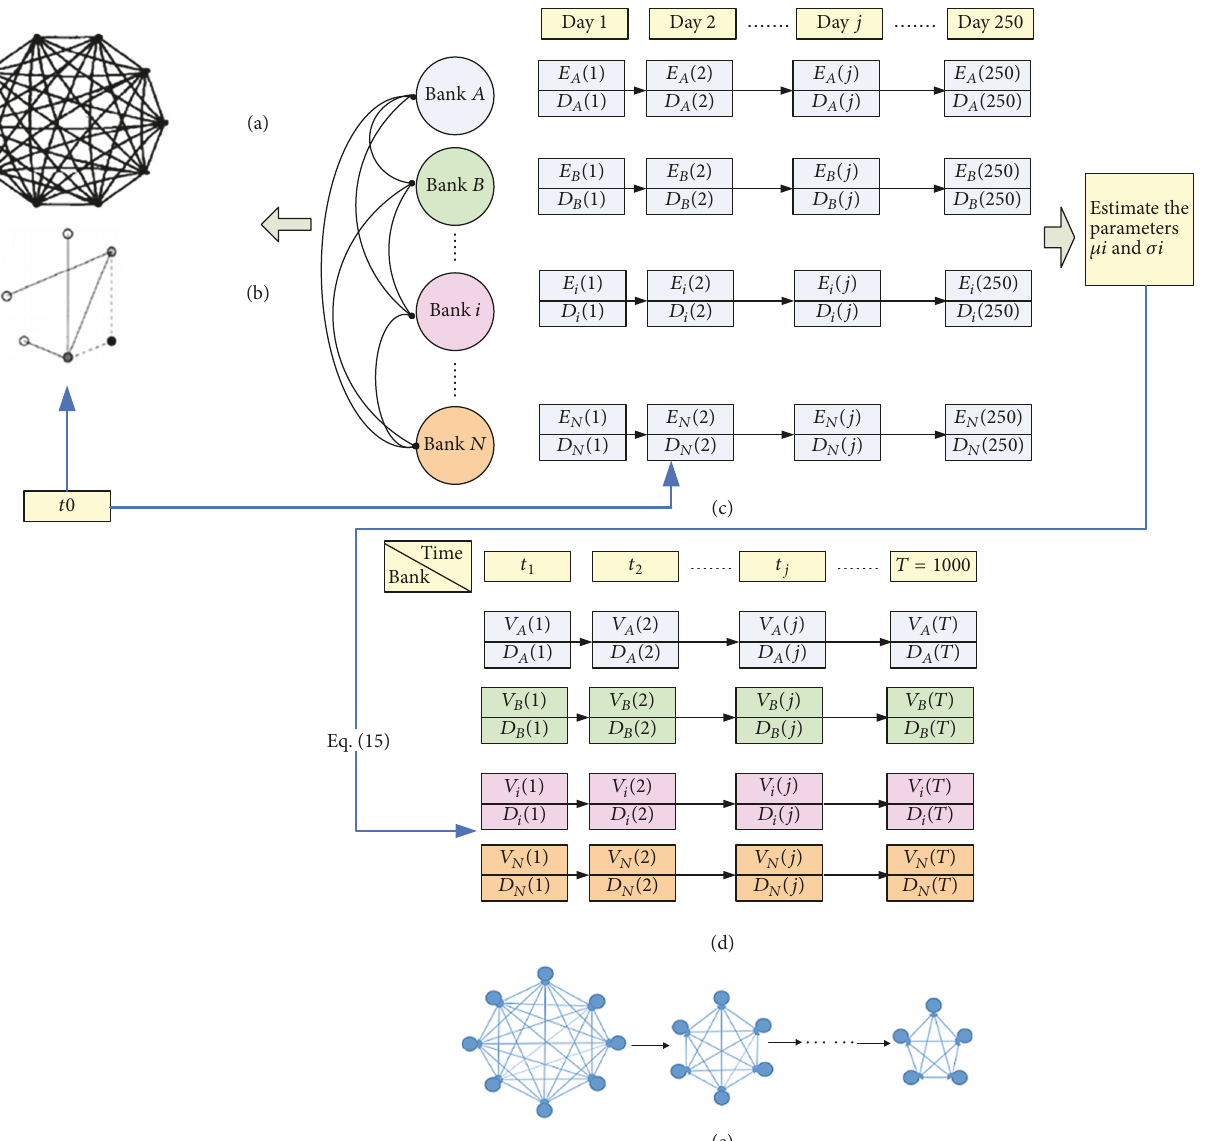
Figure 1: The dynamic theory framework of assessing systemic